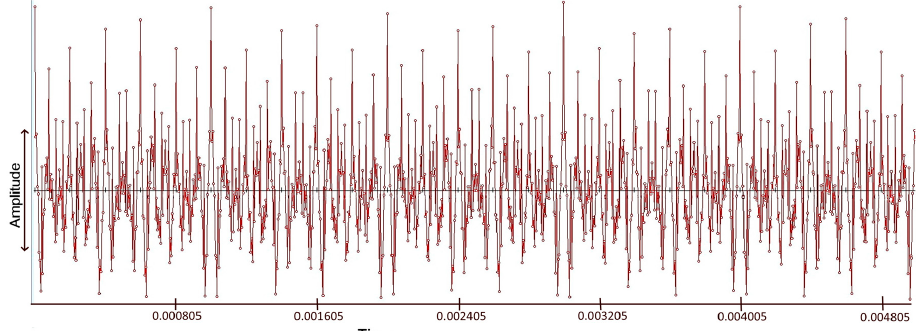
Figure 7. Relationship between the synthesized test signal of the oscillatory process and the time.